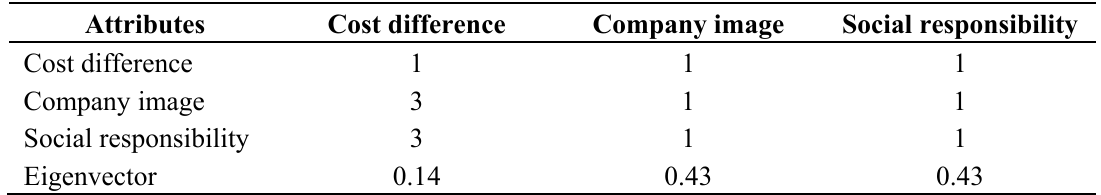
Table 4. Weighting value of green attractions: comparison of cost difference, company image, and Social responsibility.